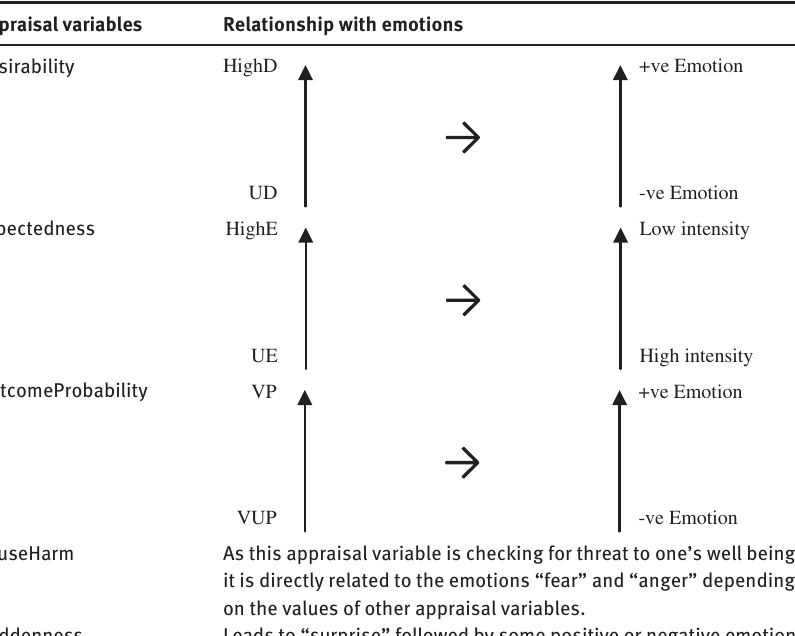
Table 2. Appraisal Variable to Emotion